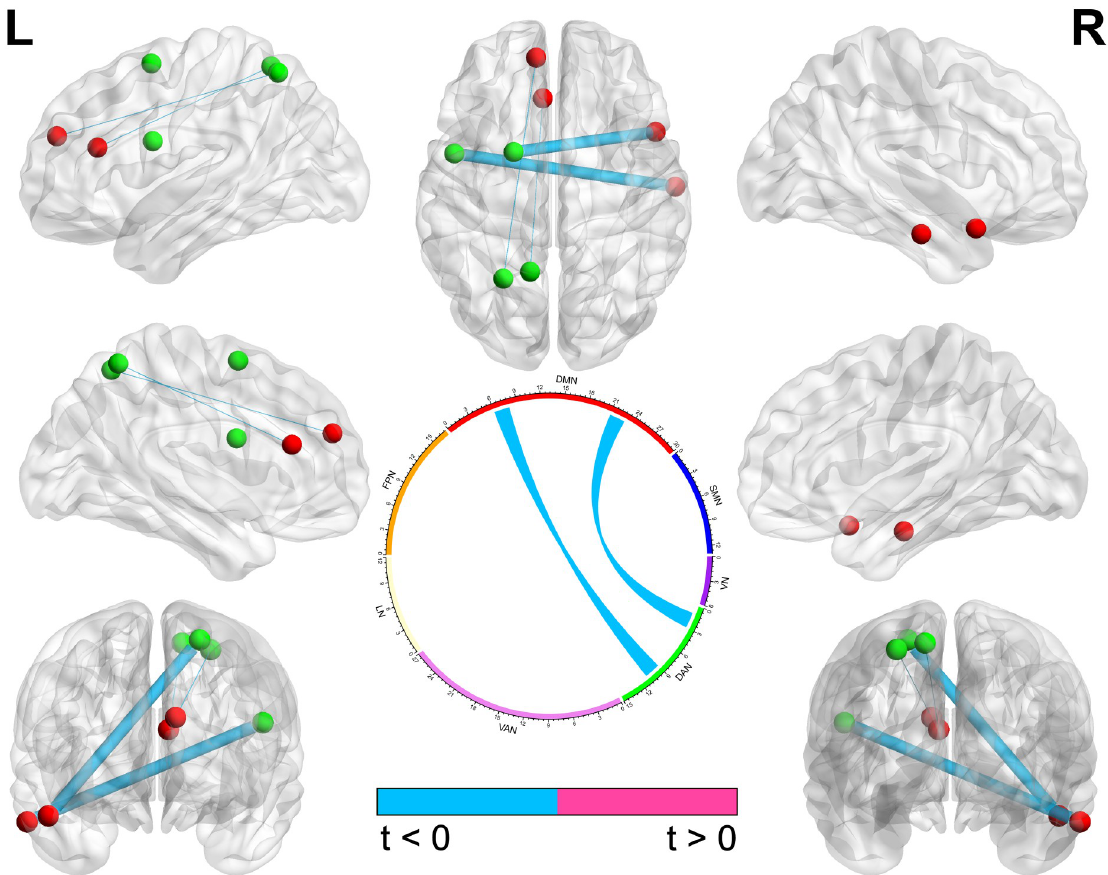
Fig 5. The changed functional connections of brain nodes in the HC group with P < 0.05 between interventions. The different colors of brain nodes represent different brain networks. The thickness of nodes’ connections represents the statistical value between interventions. The statistical value that was decreased after the intervention is displayed with blue color and that which was increased with pink color.